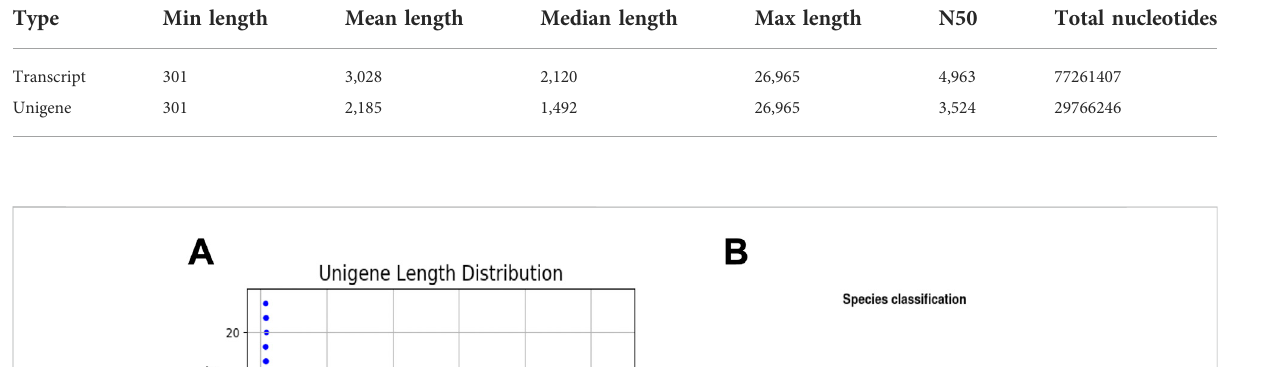
TABLE 2 De novo transcriptome analysis in F. solani species complex bio fi lm and identi fi cation of critical genes involved in 1,8-cineole treatment. TABLE 3 Summary statistic of F. solani species complex bio fi lm transcriptome